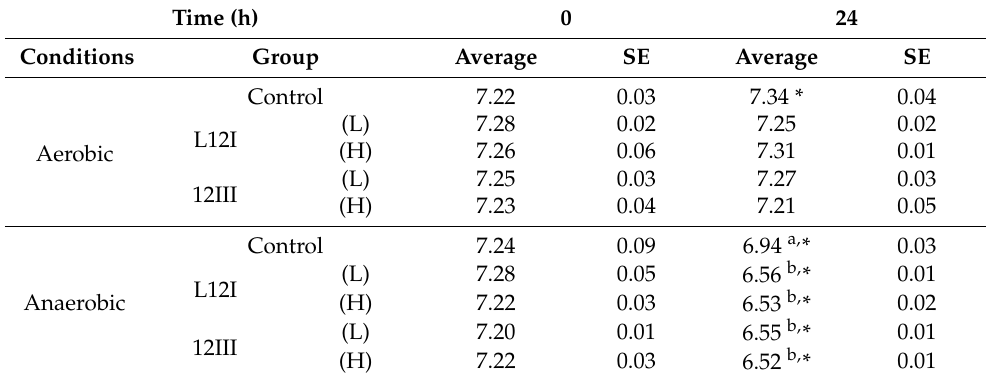
Values represent the mean ± S.E. ( n = 3). * p < 0.05 vs. 0 h indicates statistical significance. The different letters (a, b) indicate statistically significant difference between different groups at the same time and same conditions (significance level at p < 0.05).